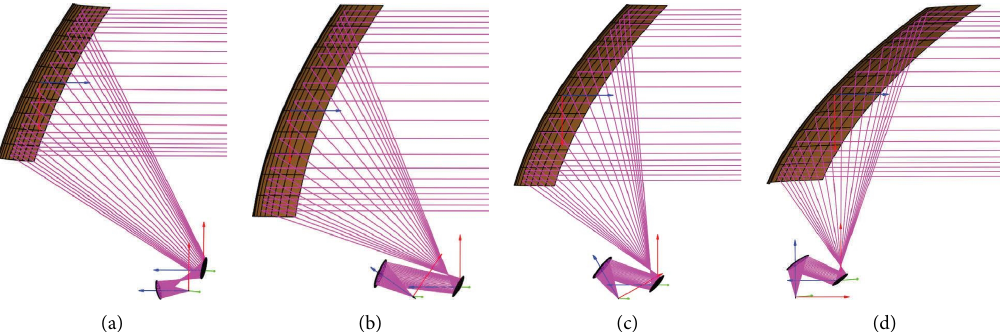
Figure 5: Four tri-refector CATRs corresponding to diferent geometric confguration forms for diferent feed rotation angles. (a) θ (b) θ 0 � 30 ° . (c) θ 0 � 60 ° . (d) θ 0 � 90 ° .